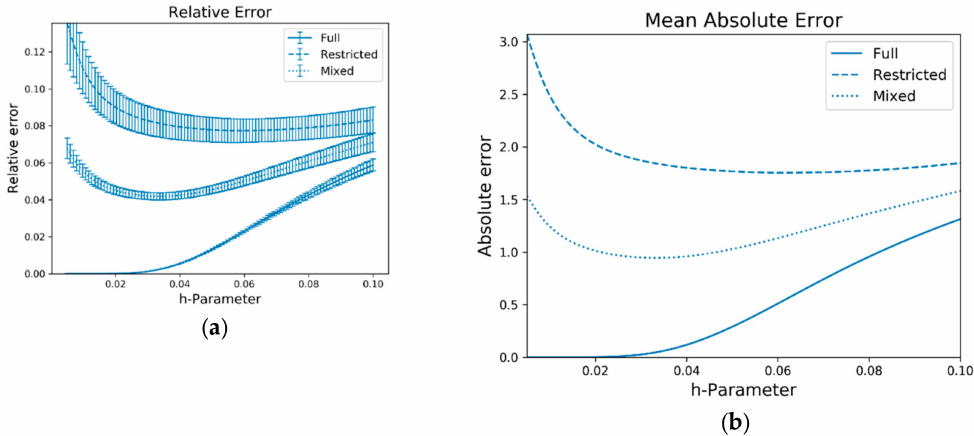
Figure 4. Results of the heating load problem for the full, partial, and mixed models with the parameter selection h = ω . ( a ) Mean absolute percentage error (MAPE) depending on h ; ( b ) Mean absolute error (MAE) depending on h